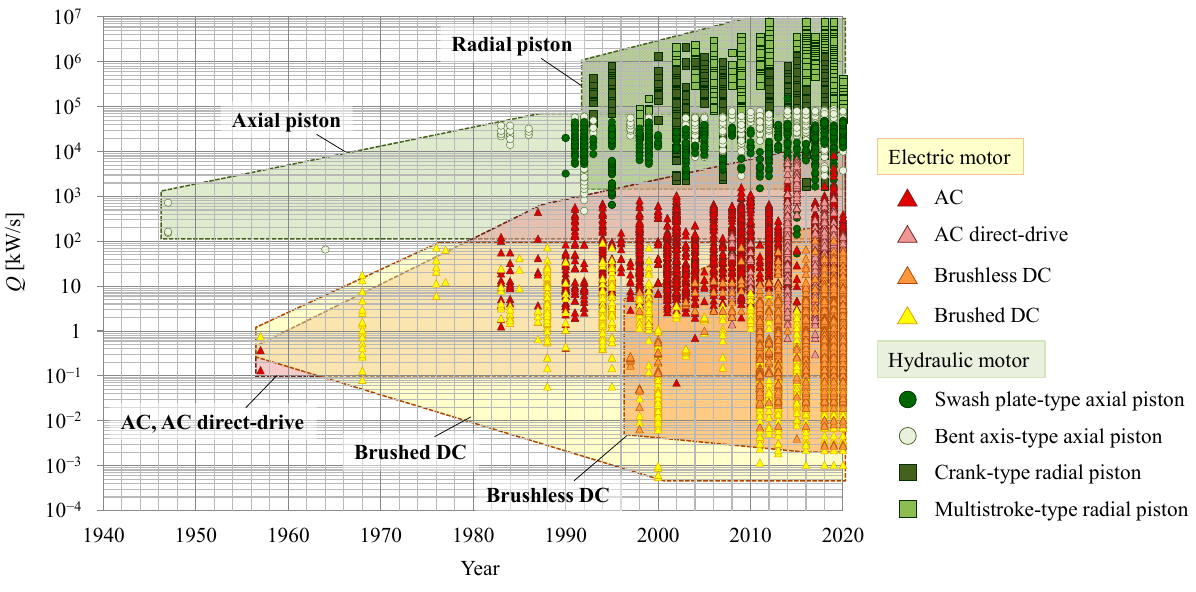
Figure 6. Transition of power rate.